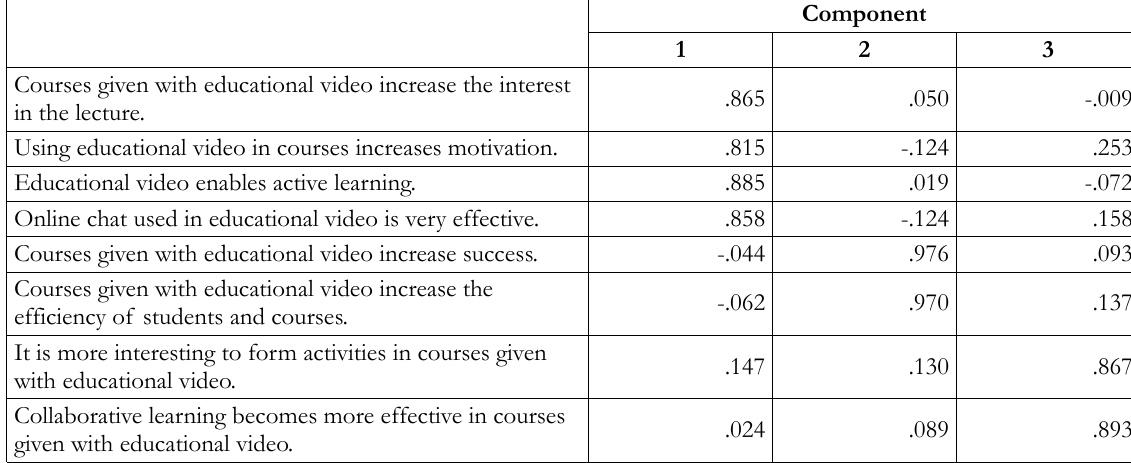
Table 1. The three factors of the